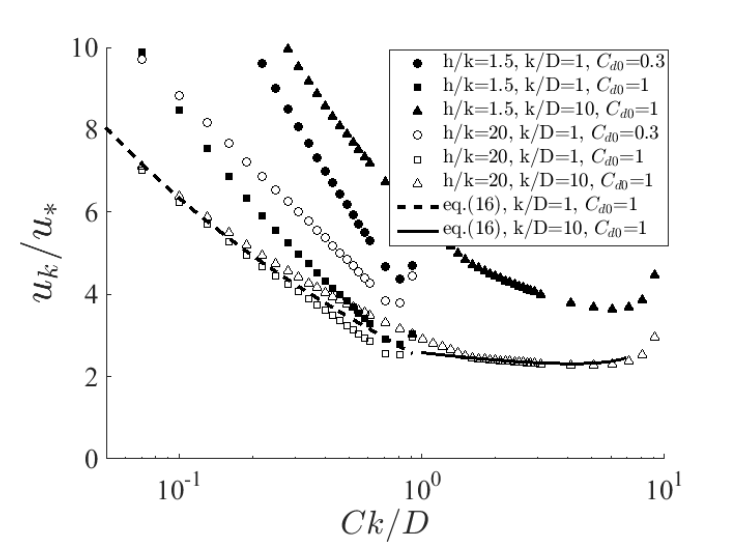
Figure 16. Ratio between shear velocity and velocity at the top of the canopy as a function of the spatial